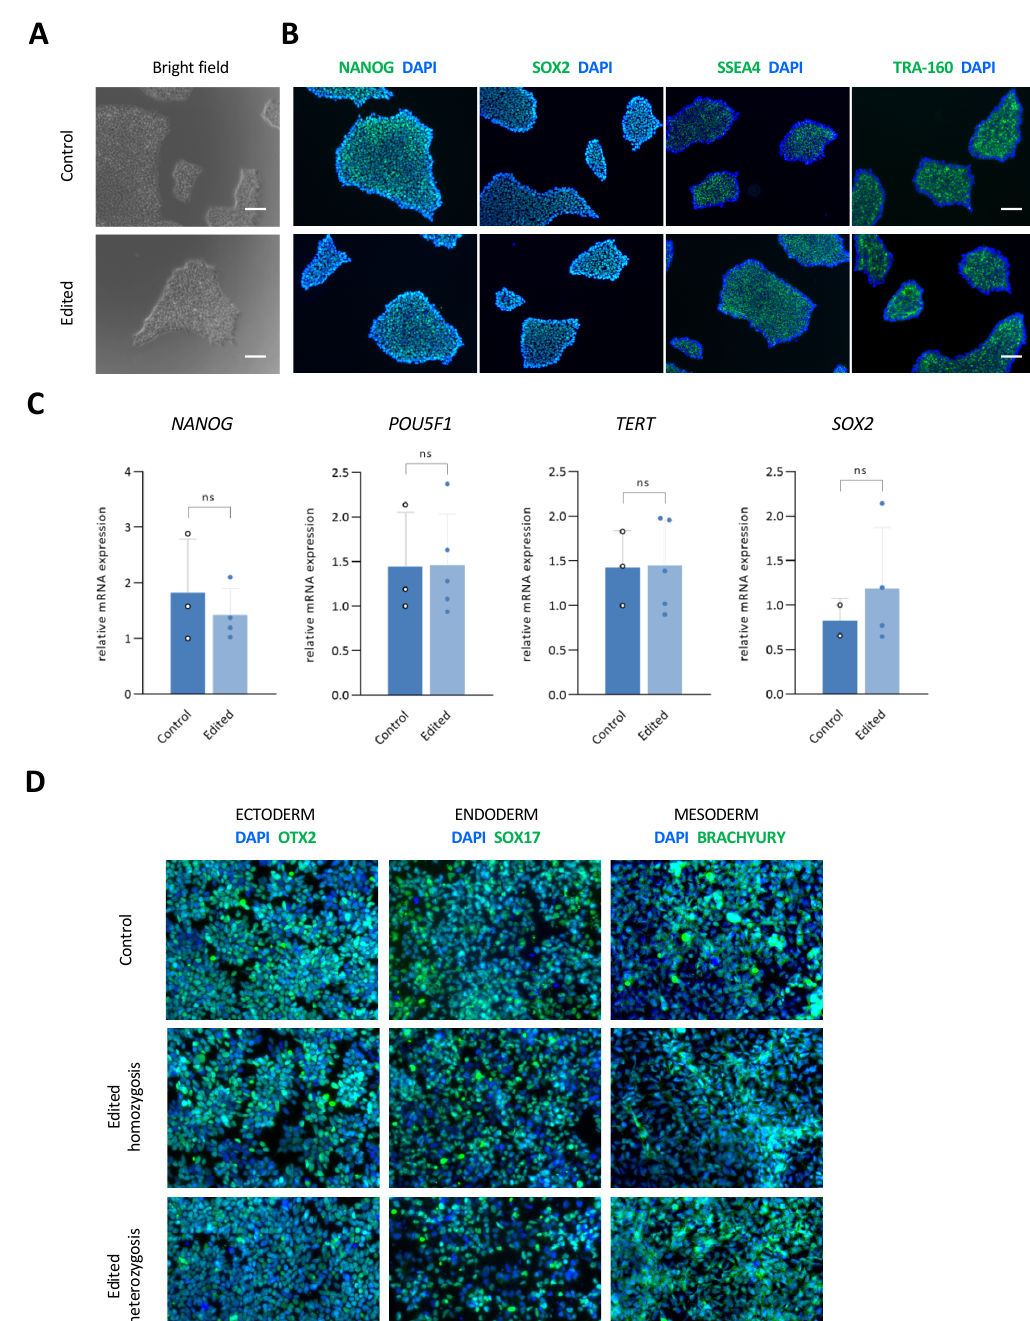
Figure 4. Single-nucleotide gene editing preserves hiPSCs’ pluripotency and renders no genomic alterations in potential off-targets. ( A ) Bright-field pictures of control and homozygous edited FRIMOi007-A clones showing colony morphology after CRISPR/Cas9. Scale bar represents 100 µ m. ( B ) As in ( A ), but cells were stained to assess the expression of the pluripotency markers NANOG, SOX2, SSEA4, and TRA-160 by immunofluorescence with AF-488 (in green) and counterstained with DAPI. Representative captures are shown. Scale bar represents 100 µ m. ( C ) Relative mRNA expres- sion of pluripotency markers NANOG , POU5F1 , TERT , and SOX2 in control and homozygous edited clones. At least two clones were assessed for quantification. ( D ) Immunofluorescence assessment of OTX2, SOX17, and BRACHYURY differentiation markers in control and edited clones. Scale bar represents 50 µ